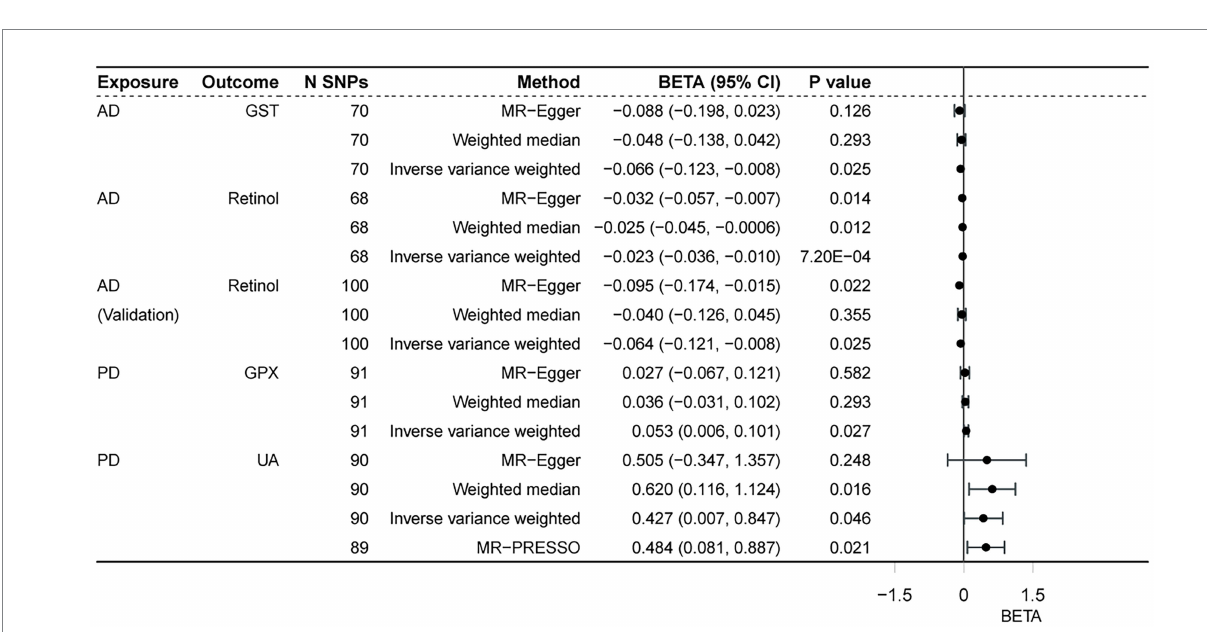
FIGURE 3 Associations of neurodegenerative disorders and antioxidant biomarkers. AD, Alzheimer’ s disease; PD, Parkinson’ s disease; GST, glutathione S-transferase; GPX, glutathione peroxidase; UA, uric